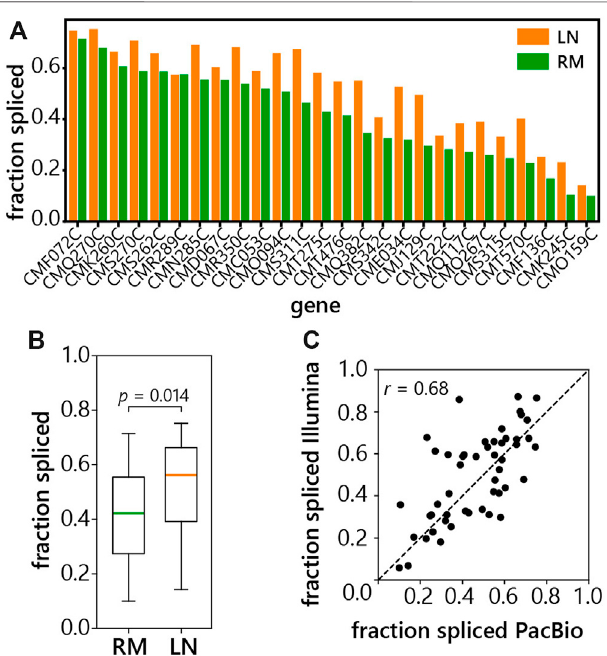
FIGURE4| Splicingef fi ciencyof C.merolae intron-containinggenes. (A) LRS was used to measure the fraction of reads that were spliced at each intron-containing gene in C. merolae , fraction spliced was calculated as in Figure 1B (see above), LN (low-nitrogen, orange), RM (rich media, green). (B) Box plot of a fraction of spliced reads grown in RM or LN. Signi fi cance of the difference between fraction of spliced reads was tested by two-sided Mann-Whitney U test. (C) Correlation of fraction of spliced reads obtainedfromtheshort-read(Illumina)andlong-read(PacBio)librariesprepared from samples of C. merolae. Fraction spliced was calculated as the number of intron-spanningreadswhichwerespliceddividedbythetotalnumberofintron- spanning reads for each gene shown. Pearson ’ s correlation (cid:1)